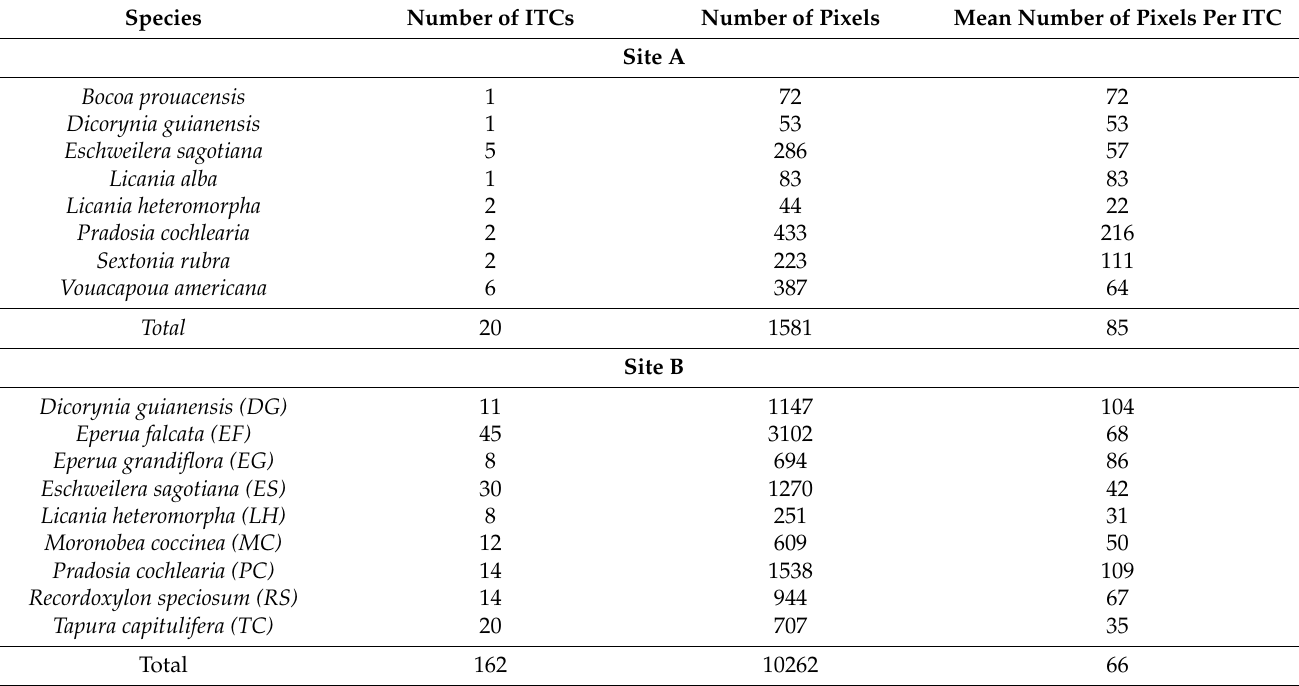
Table 1. Statistical description of ITCs corresponding to the nine most abundant species delineated in site A and